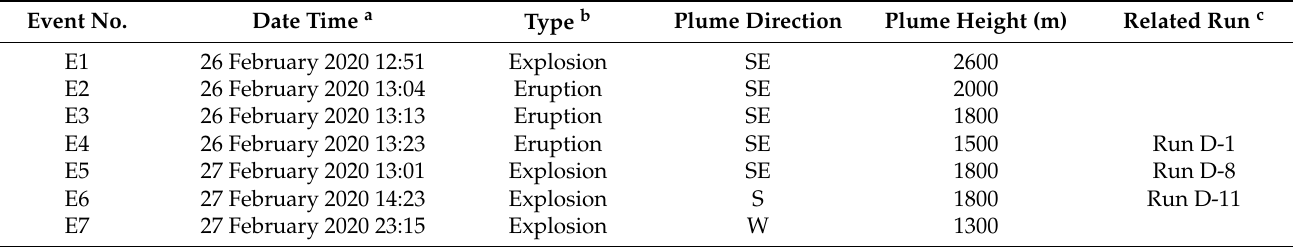
a Local time (JST; Japan Standard Time). b Explosion: infrasound (>10 Pa) or the observations of falling ballistic blocks on the flank. Eruption: top of the plume reached an altitude ≥ 1000 m above the crater (excluding explosions). c The flight closest to the eruption or explosion